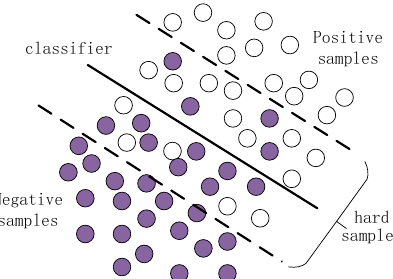
Figure 2. The relationship between classification hyperplane and samples. The white circles and the dark circles separately indicate the positive samples and the negative samples. The samples inside the dotted line are the hard samples which will not be classified correctly.